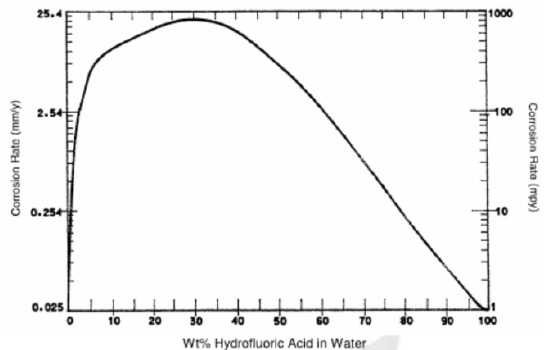
Figure 8. HF corrosion Data for Carbon Steel at 20 to 38 °C.